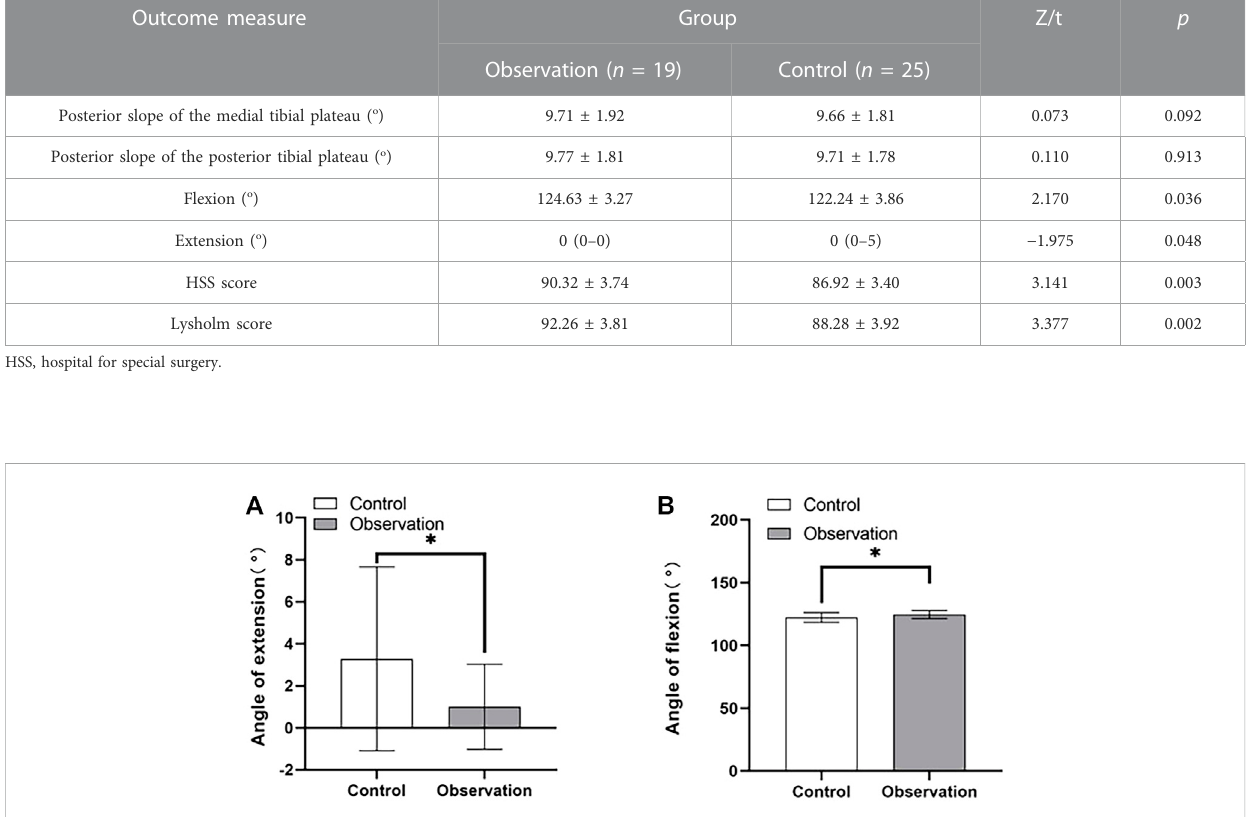
Comparison of postoperative knee fl exion and extension function between the control and observation groups. (A) Knee extension angle. (B) Knee fl exion angle. * p <